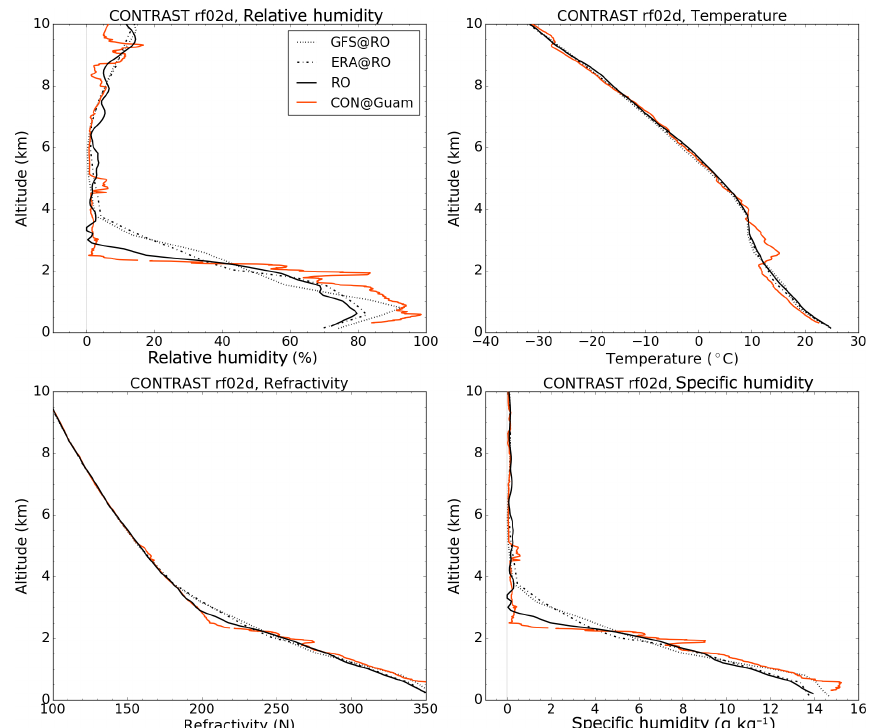
Figure 2. RH, T , N , and q profiles for CONTRAST (solid orange), RO (solid black), and RO-collocated profiles (ERA: dashed-dotted black; GFS: dotted black). Profile times and locations: CONTRAST on 14 January 2014, 00:58–01:11UT, at 19 . 2 ◦ N, 166 . 5 ◦ E; RO on 13 January 2014, 22:18UT, at 17 . 7 ◦ N, 164 . 4 ◦ E. The profiles are about 3h and 390km